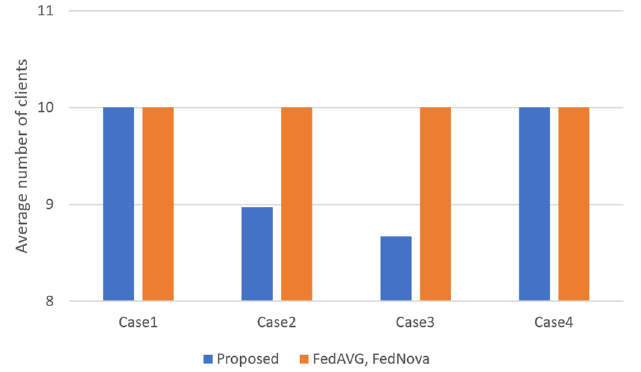
Figure 8. Average number of clients participating in the learning on different non-IID situations.